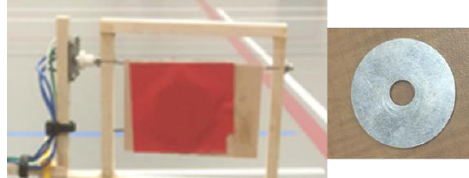
Figure 3. Air-Odo with additional weight (8 grams) added to the resisting plate to increase its velocity dynamic range.